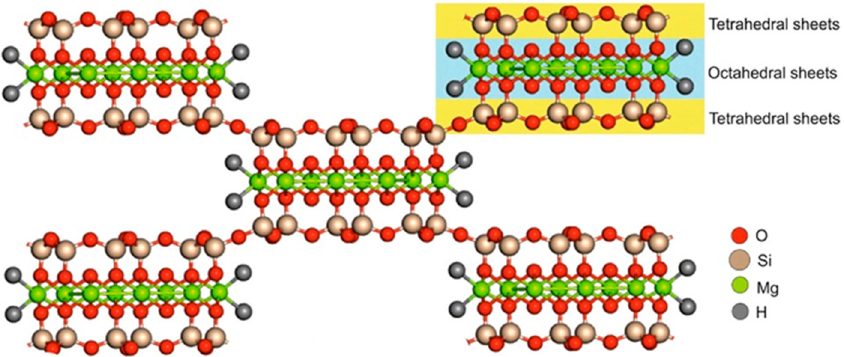
Figure 1. Sepiolite structure. Adapted from [30].